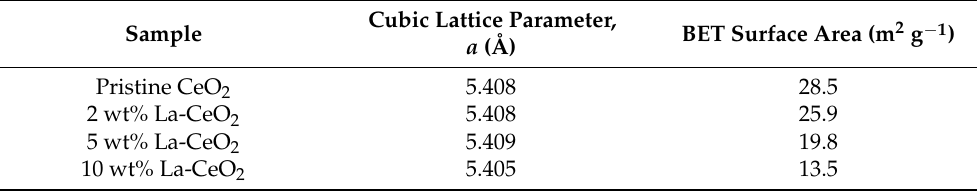
Table 1. Cubic lattice parameter and BET surface area of the pristine CeO 2 and the La-doped CeO 2